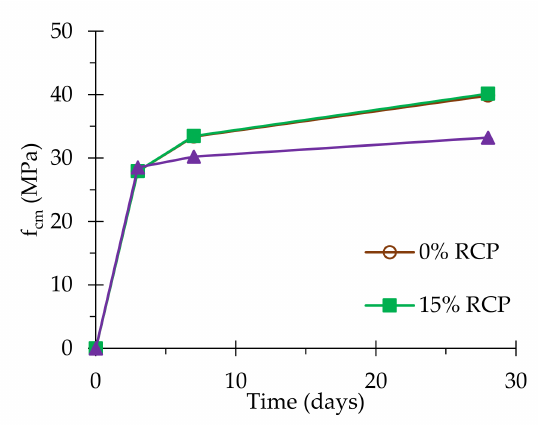
Figure 11. Compressive strength, f cm , over time of concrete with w/b of 0.55 and different percentages of RCP.